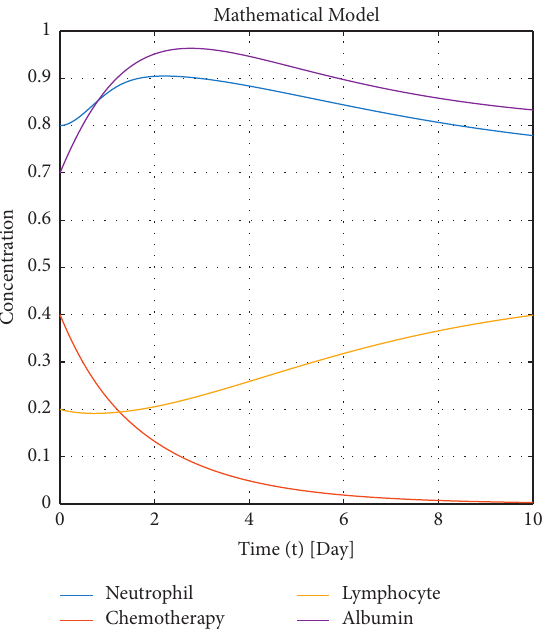
Figure 2: The dynamics of change in N, C, L, and A over time until t � 10 in the first case.